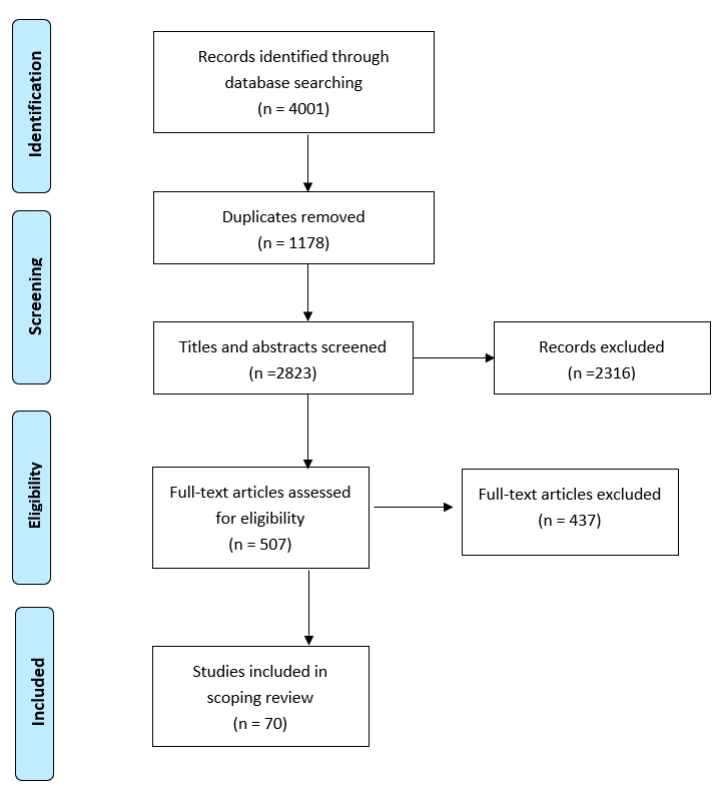
Figure 1. Flow diagram for scoping review showing literature search and selection.